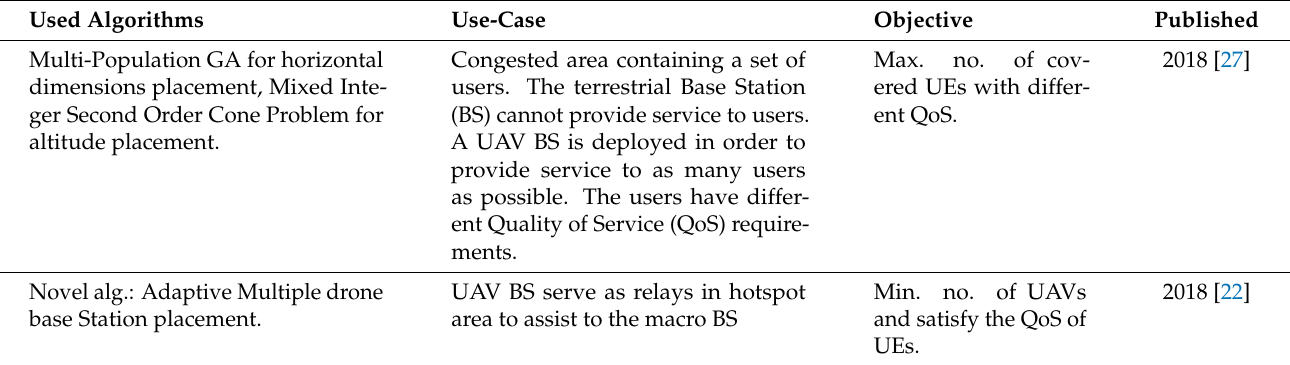
Table 1. Summary of the most recent papers on location optimization problem in FBSs use-cases. Used Algorithms Use-Case Objective Multi-Population GA for horizontal dimensions placement, Mixed